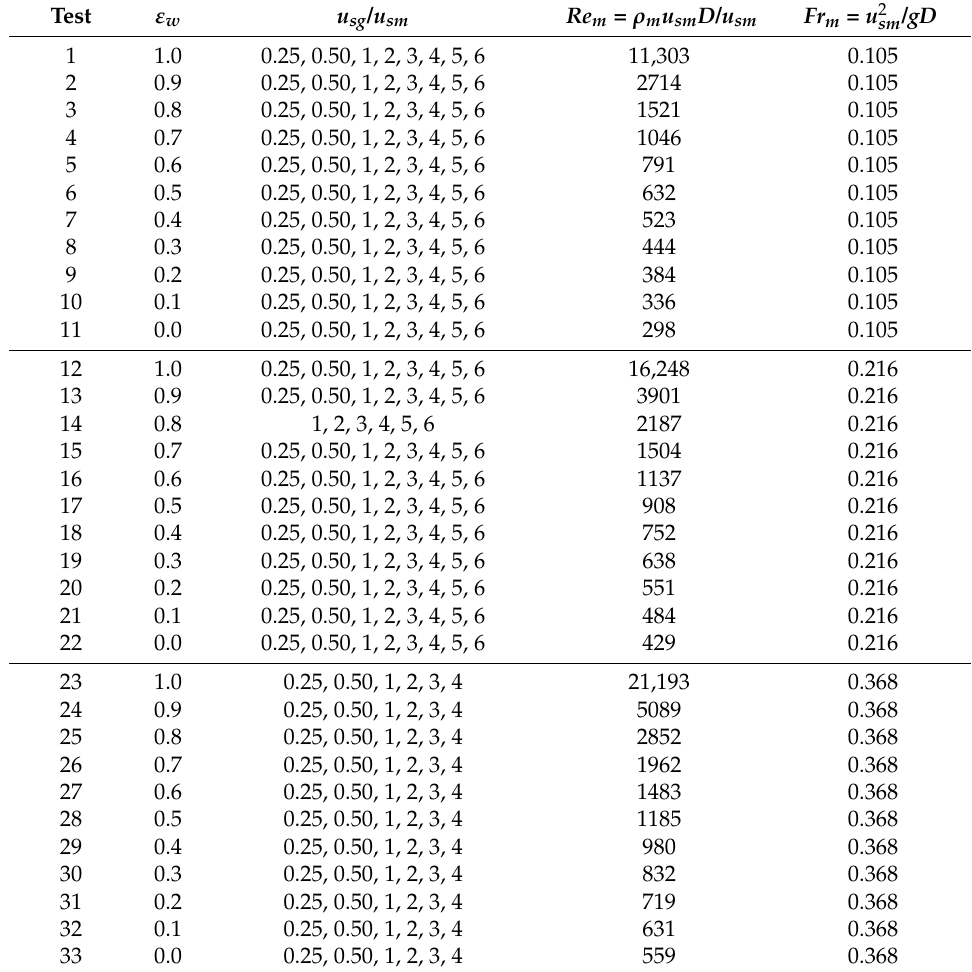
Table 2. Parameter values of flow conditions imposed during the oil–water–gas pipe flow